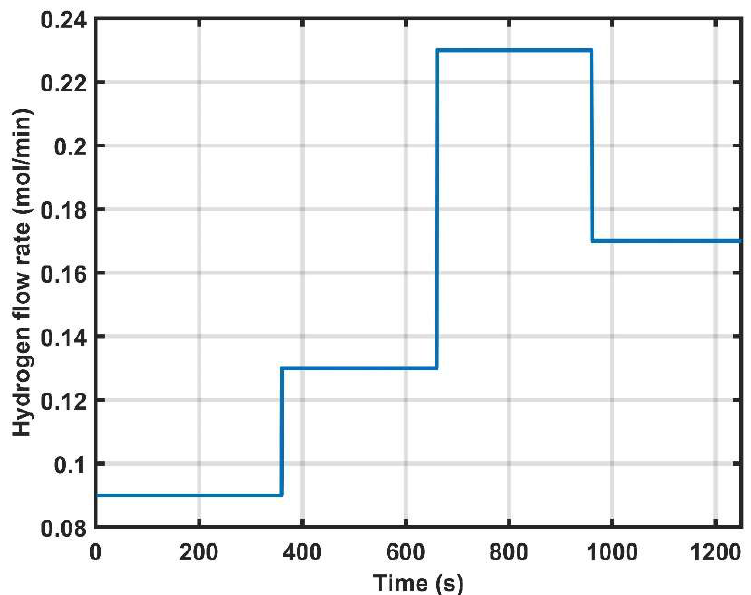
Figure 6. Schematic diagram of the hydrogen demand profile.